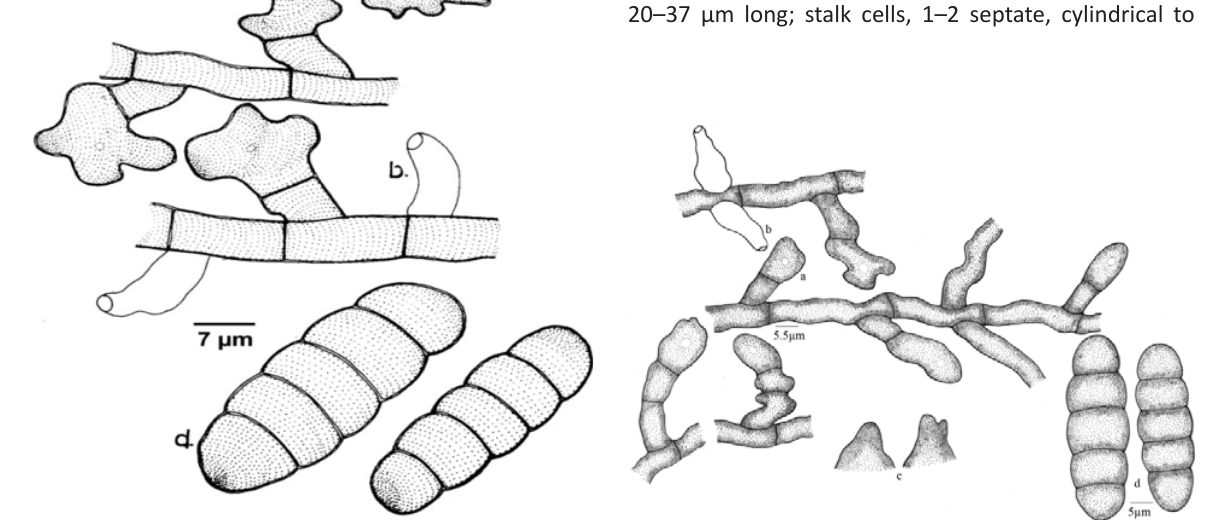
Figure 20. Asteridiella millettiicola sp. nov. a - Appressorium; b - Phialide; c - Perithecial wall cells; d - Ascospores